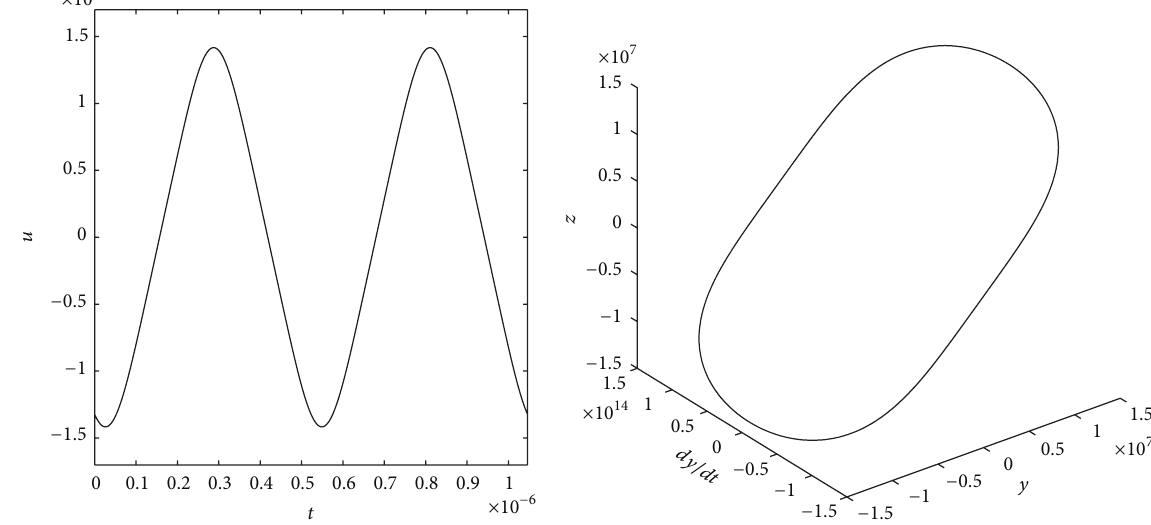
Figure 4: These results show the numerical solution 𝑥 1 (left) and the trajectories in 3D (right) for Example